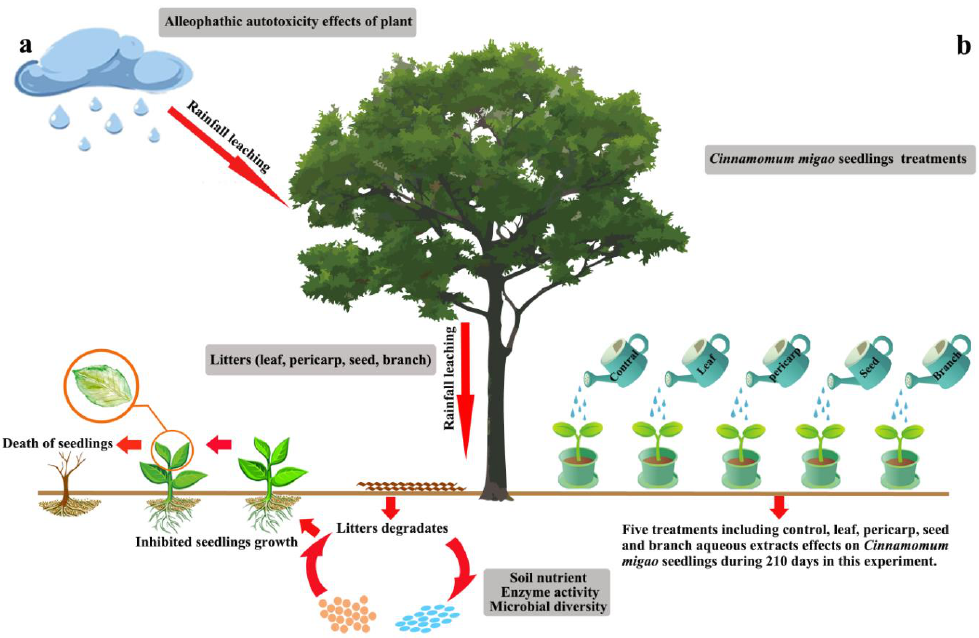
Figure 1. Process of plant autotoxicity ( a ) and our experimental design ( b ).